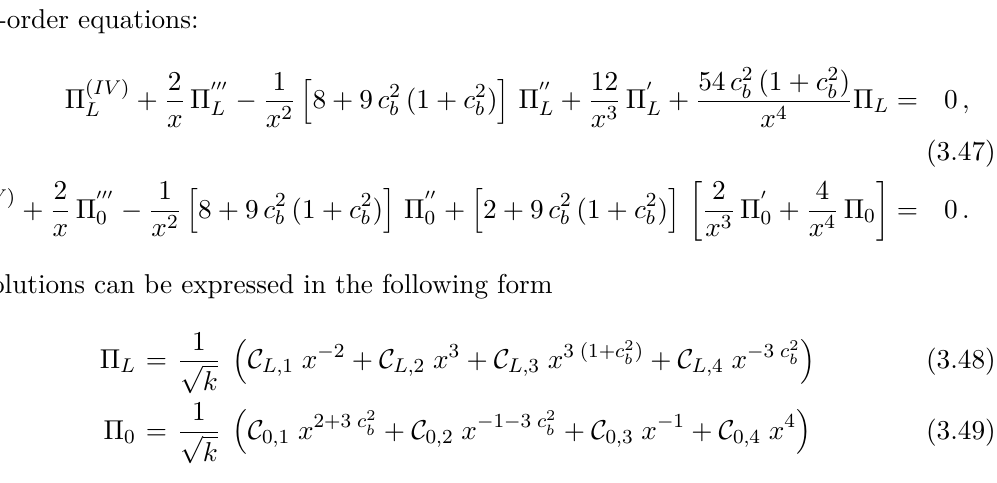
≤ 0) we give the late time structure of ζ n and R π b